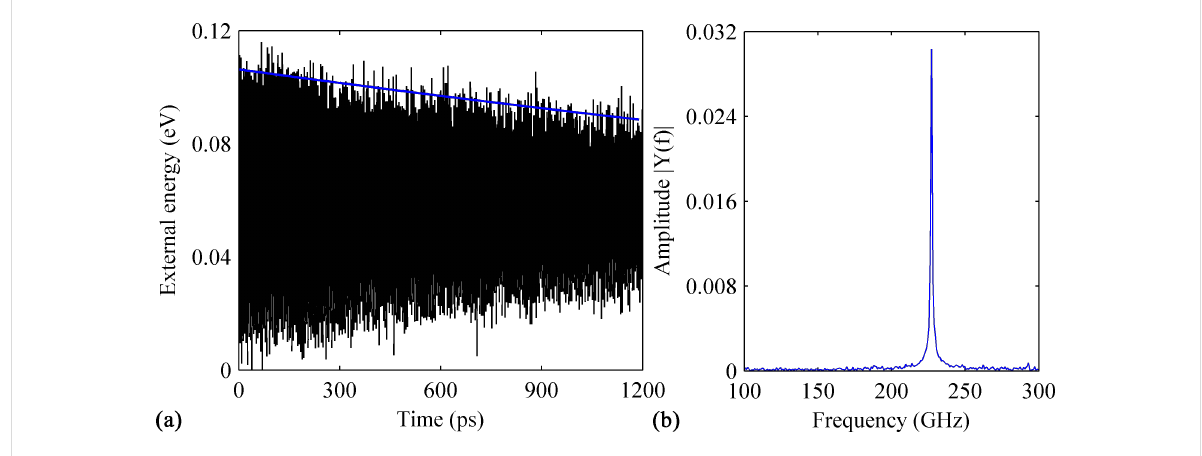
Figure 2: (a) Variation in time of the external energy obtained from a perfect GNR. (b) The corresponding frequency spectrum obtained.